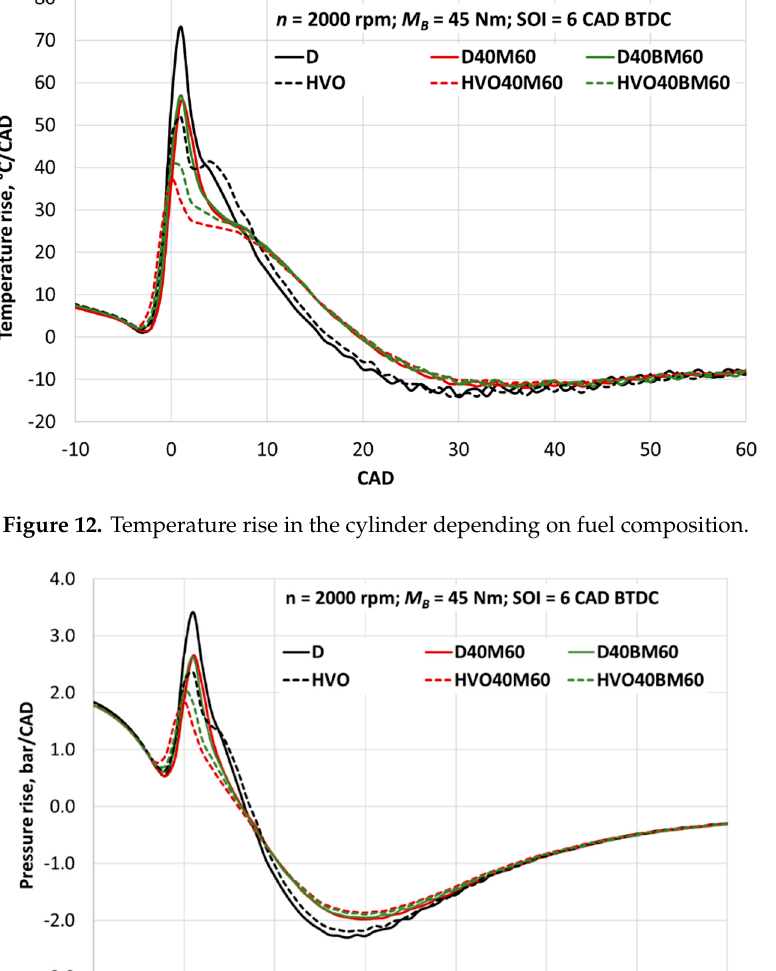
Figure 12. Temperature rise in the cylinder depending on fuel composition.